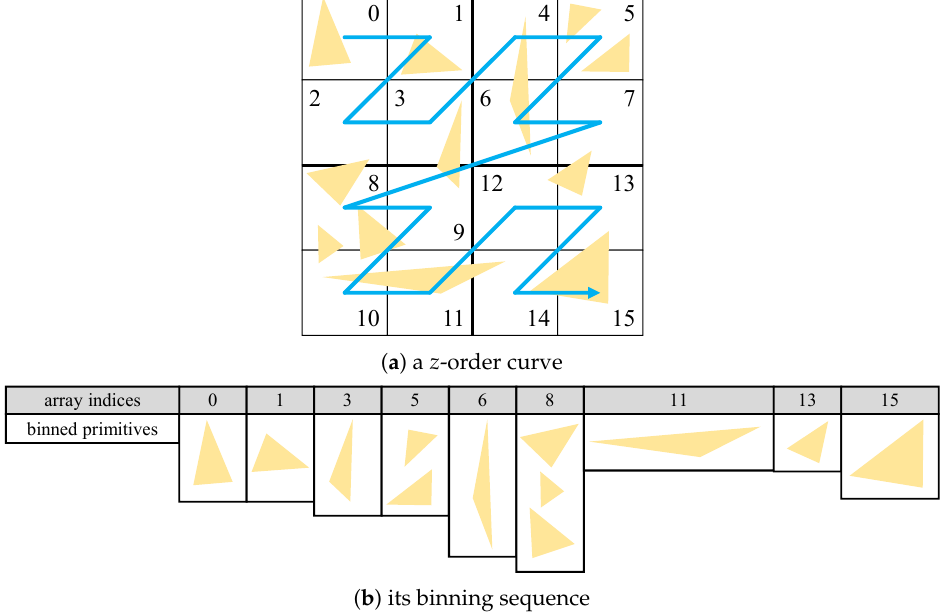
Figure 7. A z -order sequence marked on the 2D quad-tree representation, and its corresponding Morton-ordered binning